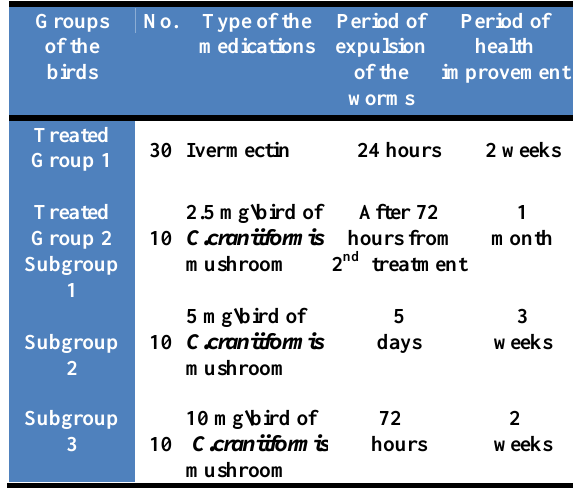
Table, 1: Reveals the groups of the birds and the type of the